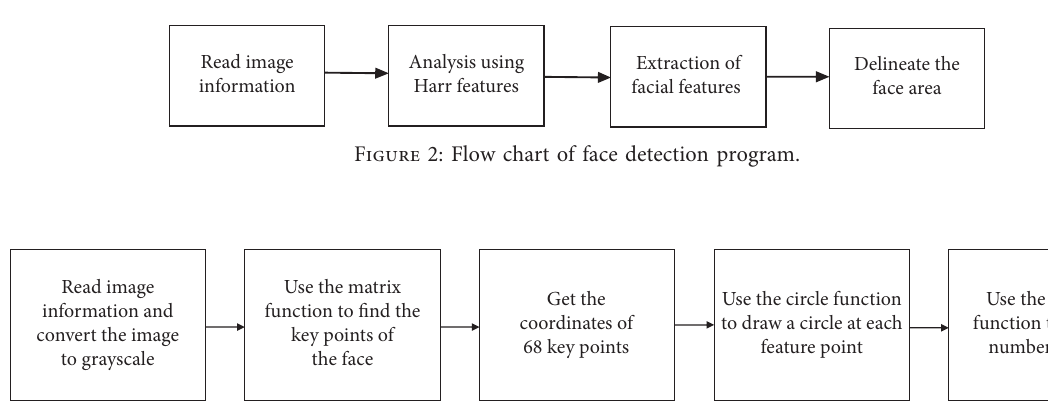
Figure 3: Flow chart of face feature point localization procedure.